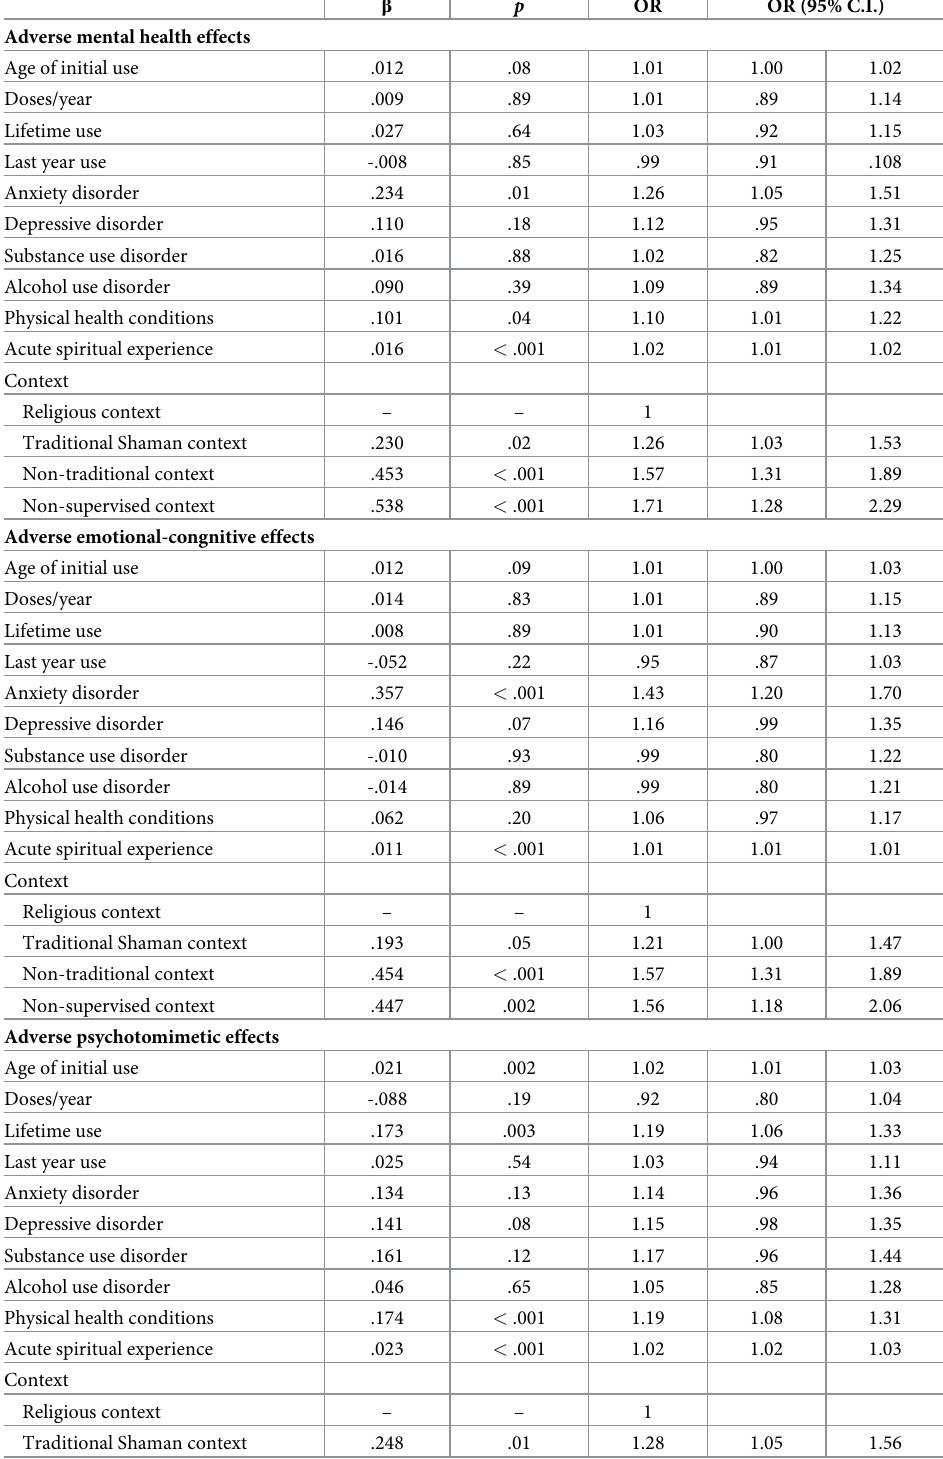
Table 6. History of ayahuasca use and medical status variables’ relationship with adverse mental health effects for each